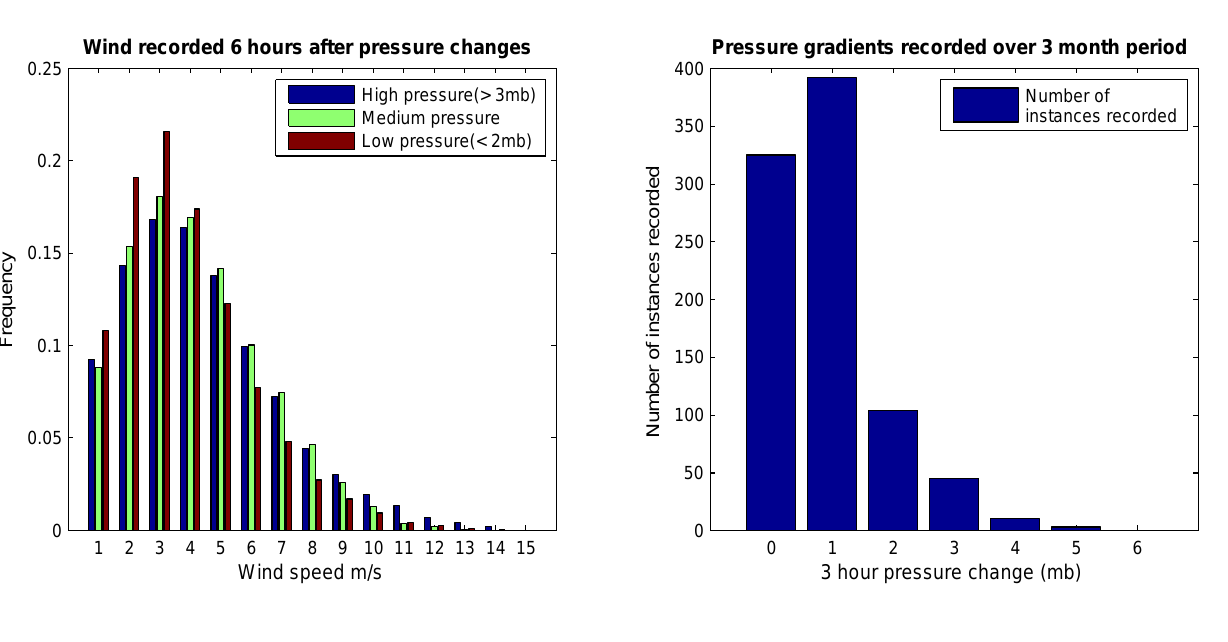
Figure 7. Normalised wind speeds recorded after pressure changes and how many of these changes that occur in a three month